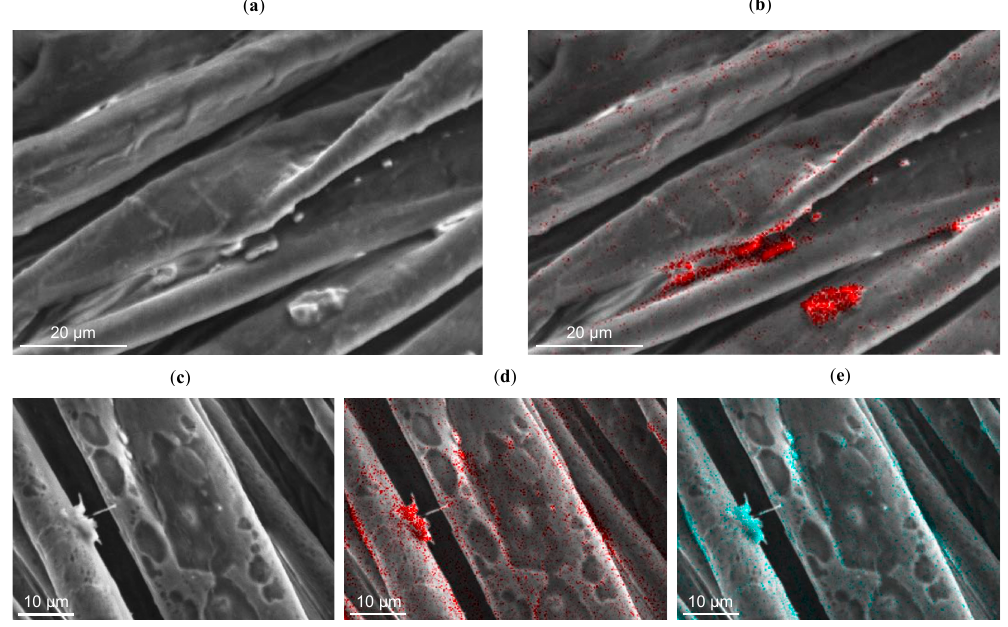
Figure 3. ( a ) SEM image of Cotton-NBB80h ; ( b ) Si map of the corresponding area; ( c ) damaged Cotton- NBB80h specimen after prolonged SEM observation, and elemental maps for Si ( d ) and S ( e ) of the sample zone shown in ( c ).